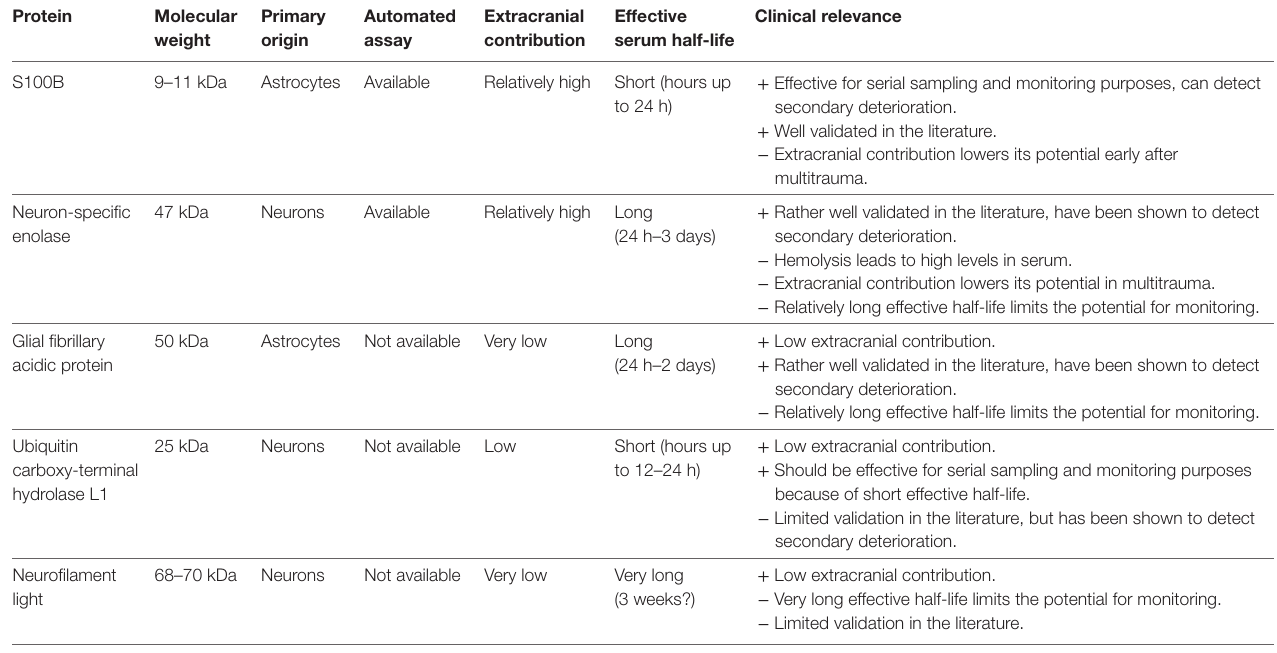
TABLe 6 | Characteristics of the selected protein